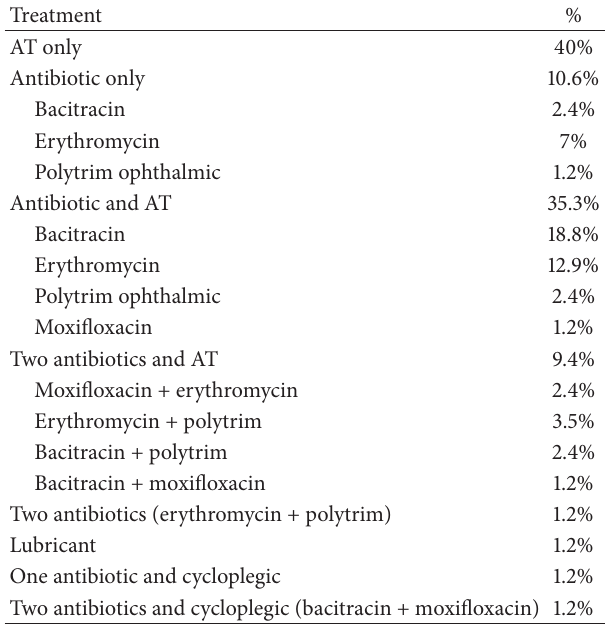
Table 3: Perioperative care factors. Table 4: Treatment for corneal